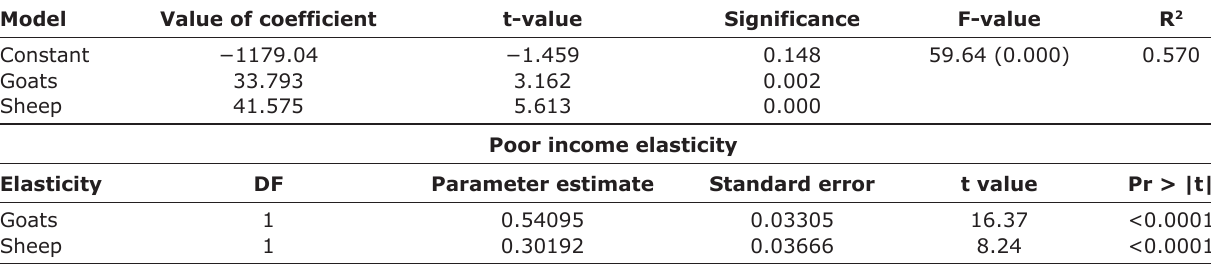
Table-4: Influence of small ruminants on per capita income of the urban poor. Model